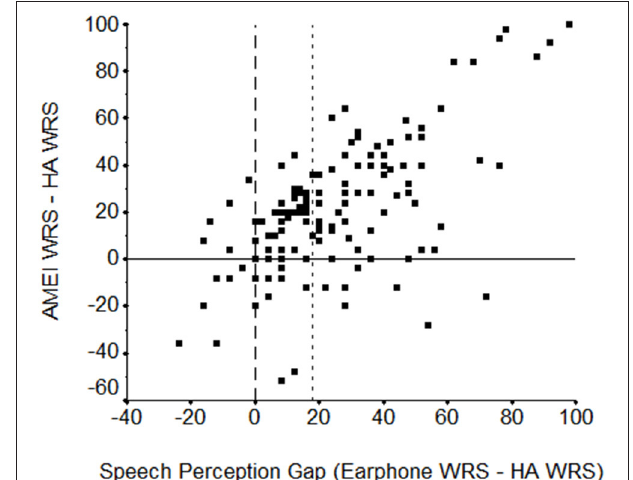
FIGURE 2 | Scatterplot of the earphone (max-WRS) minus hearing aid (HA, at 50 dB HL) word recognition score (WRS) difference in percent correct (“speech perception gap”) by the WRS difference in percent correct between the active middle ear implant (AMEI) and the HA (both at 50 dB HL). The vertical reference line at zero indicates the point of no difference between earphone and HA word recognition scores. To the left, the HA performed better while to the right, earphone performance was better. The horizontal reference line indicates the point of no difference between word recognition scores with the AMEI and HA, below which the HA performance was better and above which the AMEI was better. A second vertical reference line at 18 shows